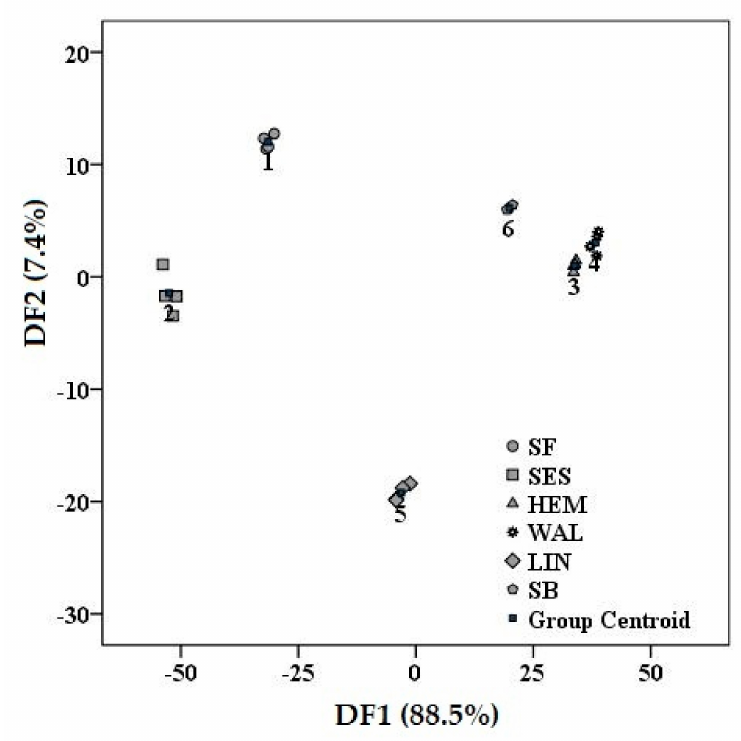
Figure 4. Classification of oil samples, based on fatty acid